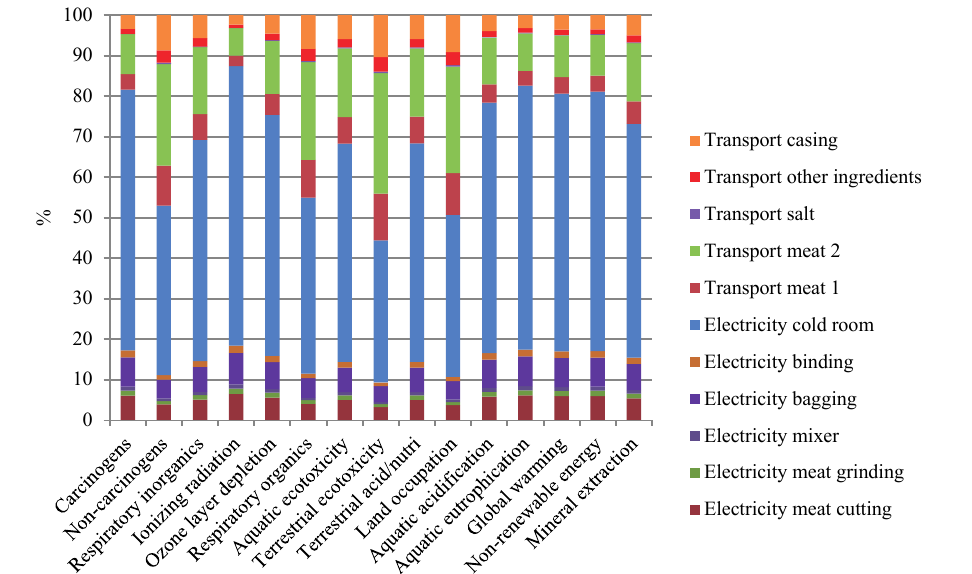
Fig. 2. Characterization impact assessment result of fresh sausage – transformation